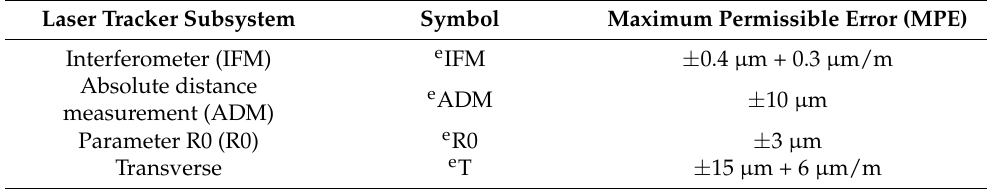
Table 1. The maximum permissible error of the Leica Absolute Tracker